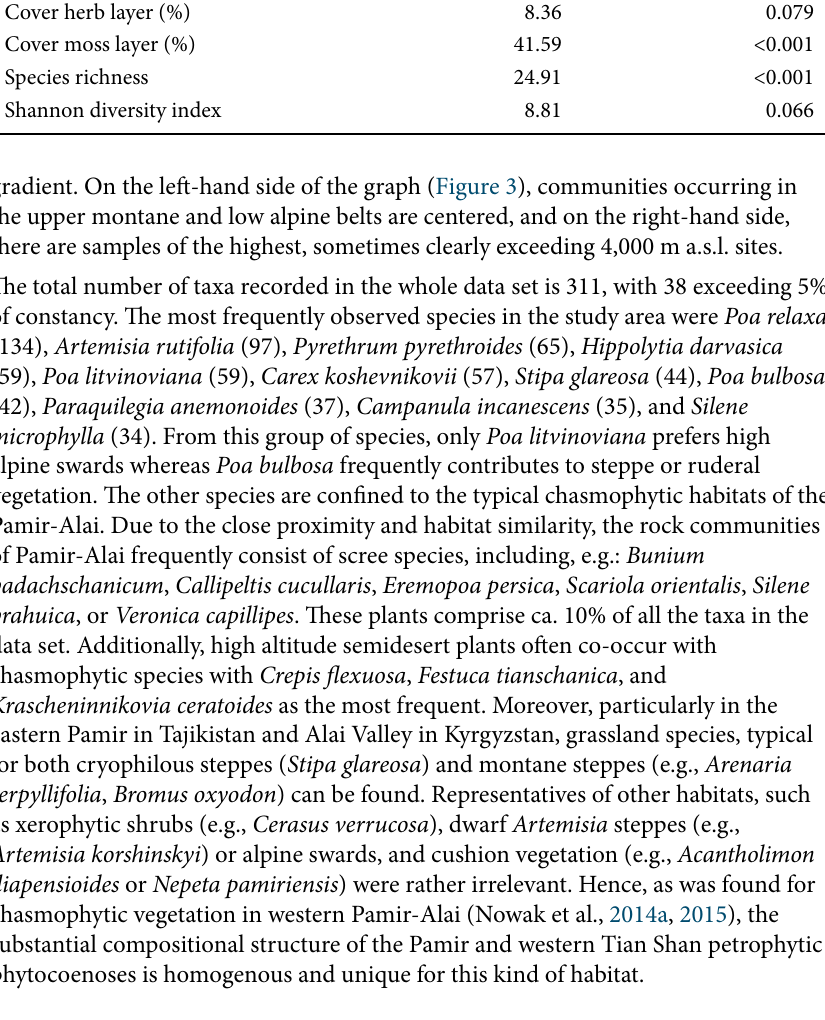
Table 1 Results of Kruskal–Wallis test for environmental and vegetation variables between identified syntaxonomical units of chasmophytic vegetation. 𝜒 2 p Altitude (m a.s.l.) 131.36 <0.001 Mean annual temperature (°C) 115.50 <0.001 Sum of annual precipitation (mm) 89.61 <0.001 Inclination (°) 43.85 <0.001 Cover herb layer (%) 8.36 0.079 Cover moss layer (%) 41.59 <0.001 Species richness 24.91 <0.001 Shannon diversity index 8.81